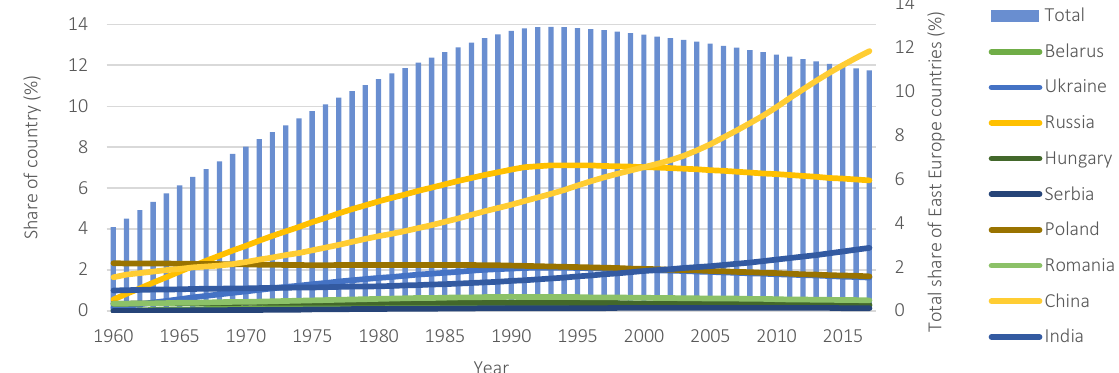
Figure 1. Global CO emissions shares of East European countries, China, and 2